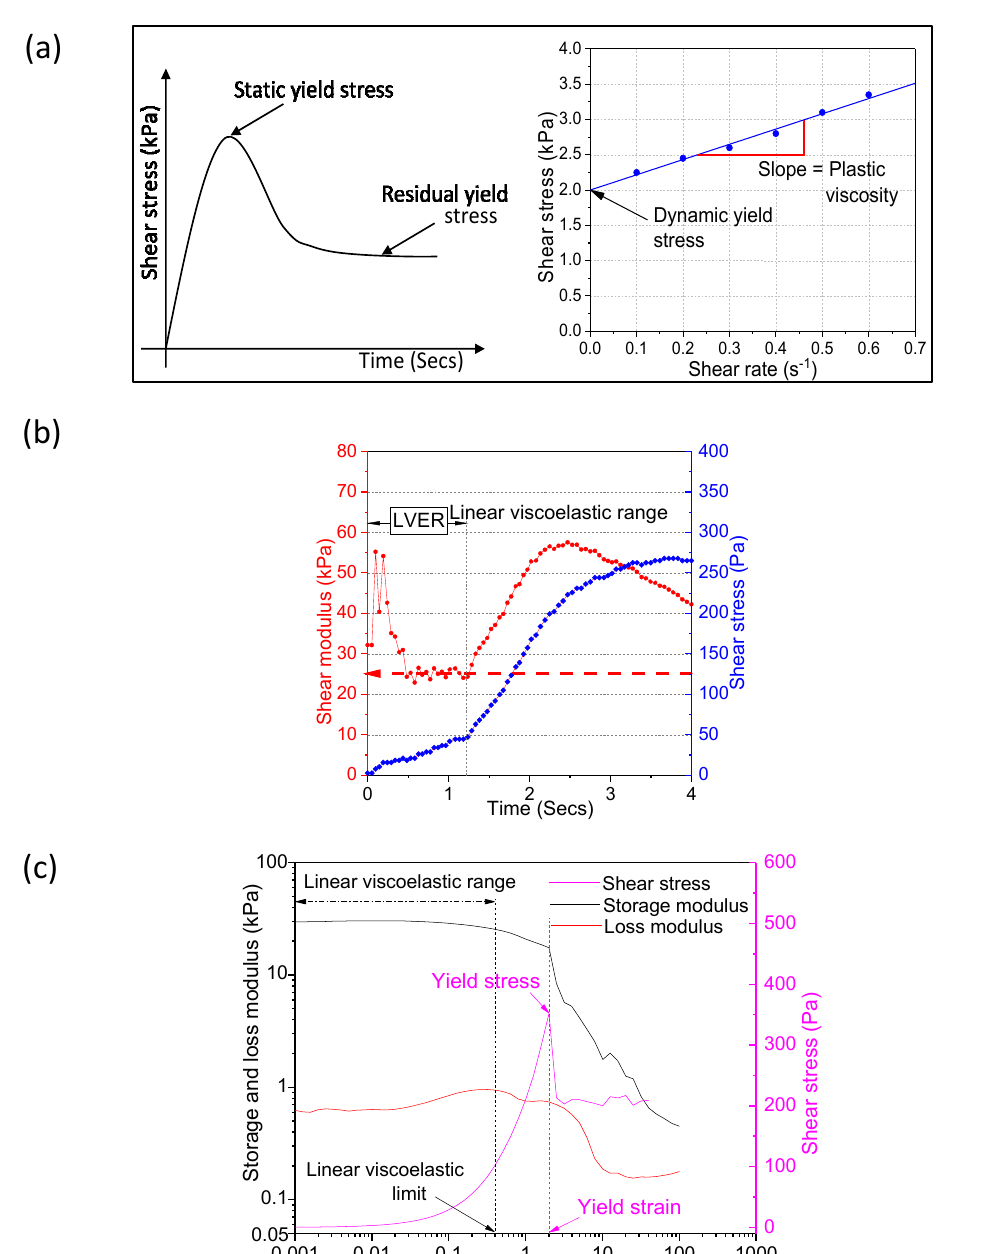
Figure 6. Typical results from (a, b) rotational shear rheometry, (c) dynamic shear